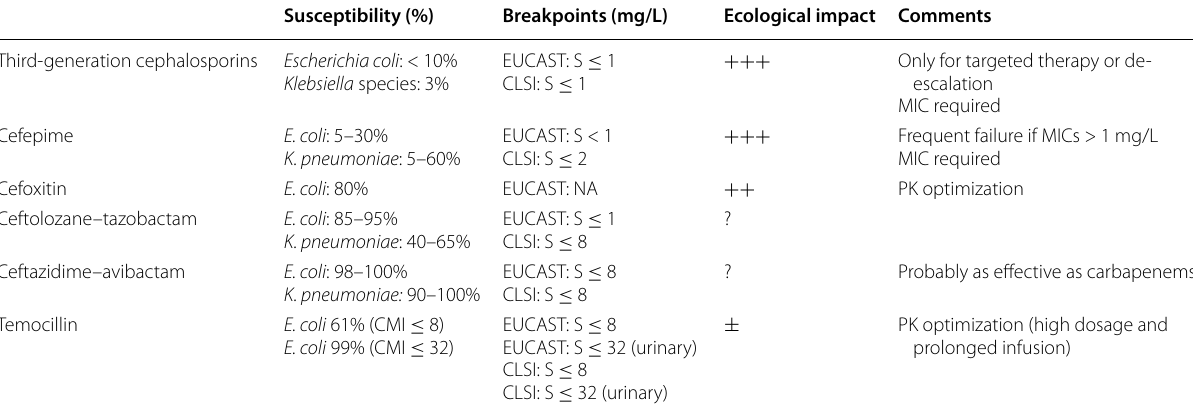
CLSI Clinical and Laboratory Standard Institute, EUCAST European Committee on Antimicrobial Susceptibility Testing, MIC minimum inhibitory concentration, NA not applicable, PK pharmacokinetic, VAP ventilator-associated pneumonia